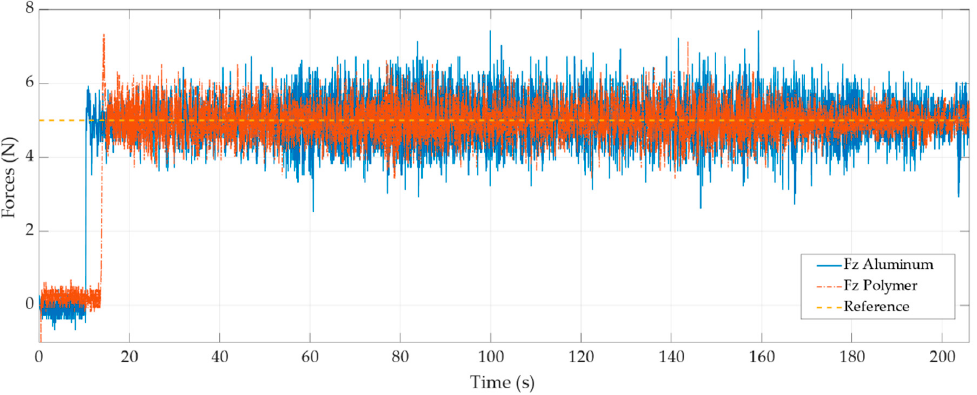
Figure 8. Force control with inner velocity loop.